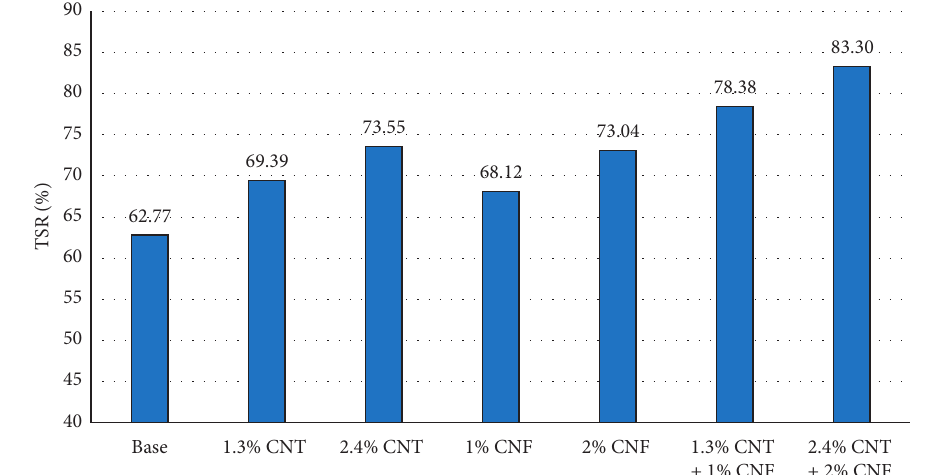
Figure 4: The results of TSR of base and modified asphalt